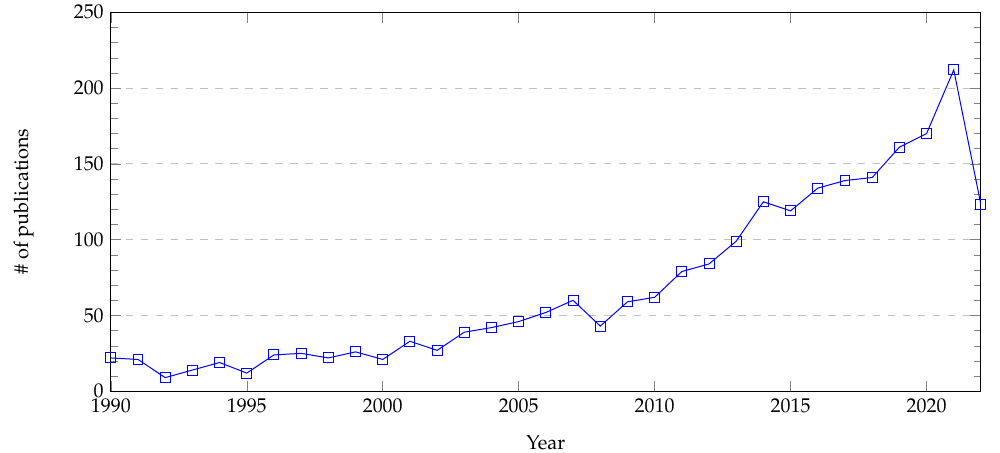
Figure 5. A timeline of rPPG-related publications every year from 1990 to 2022. For 2022, the number of publications was recorded up to 26 July